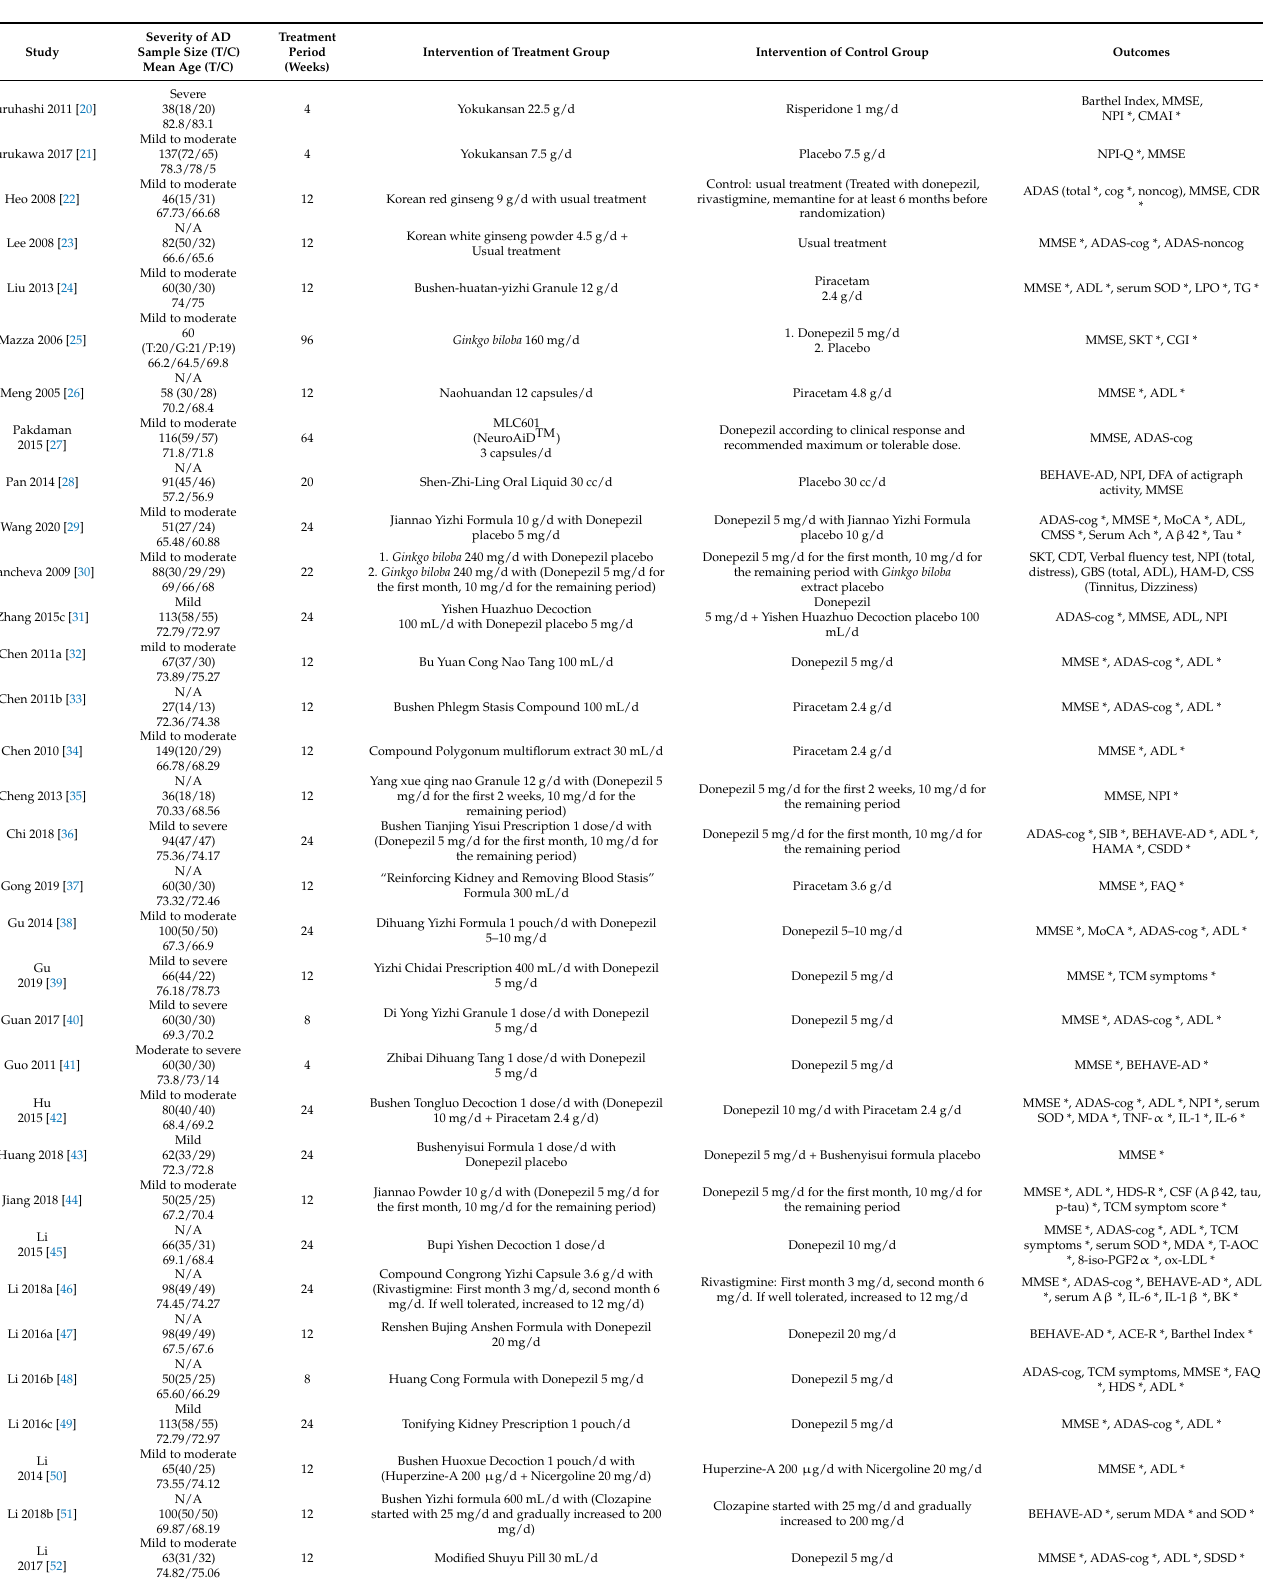
Table 1. Summaries of the included